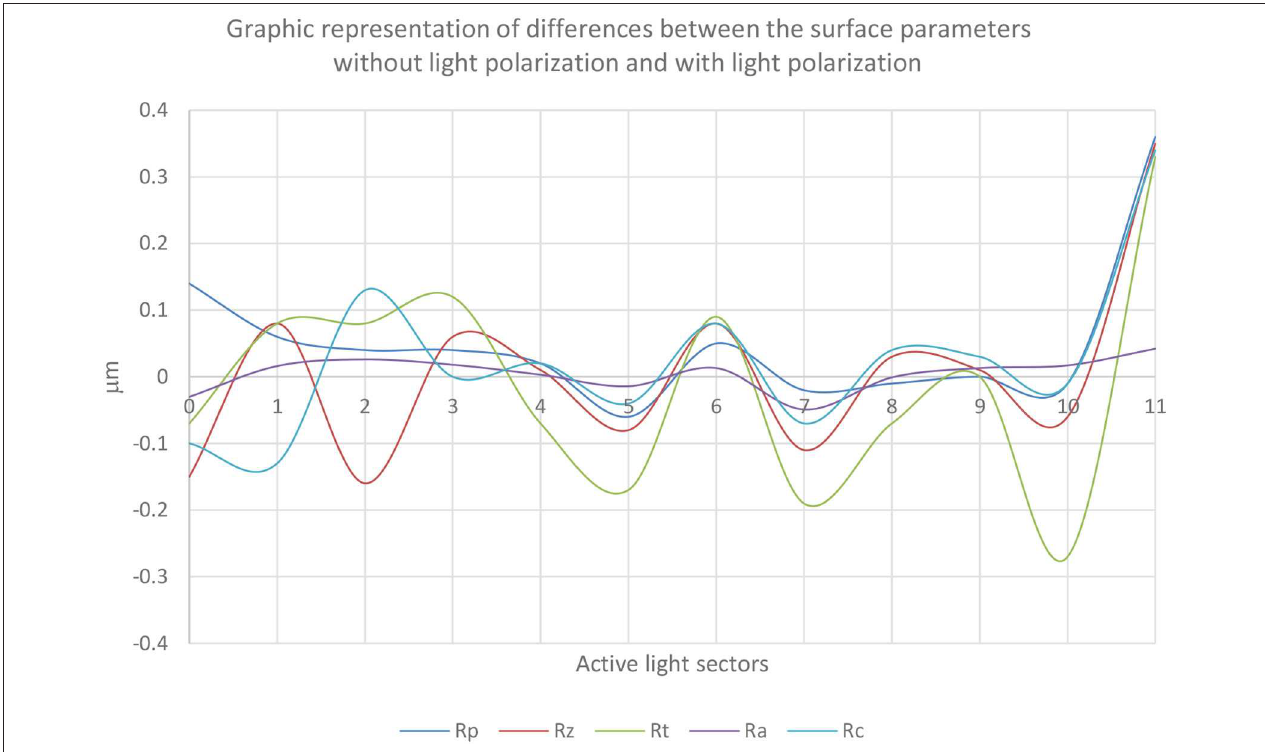
FIGURE 9 | Graphic representation of differences of the surface parameters for non-polarized and polarized light obtained at various active light